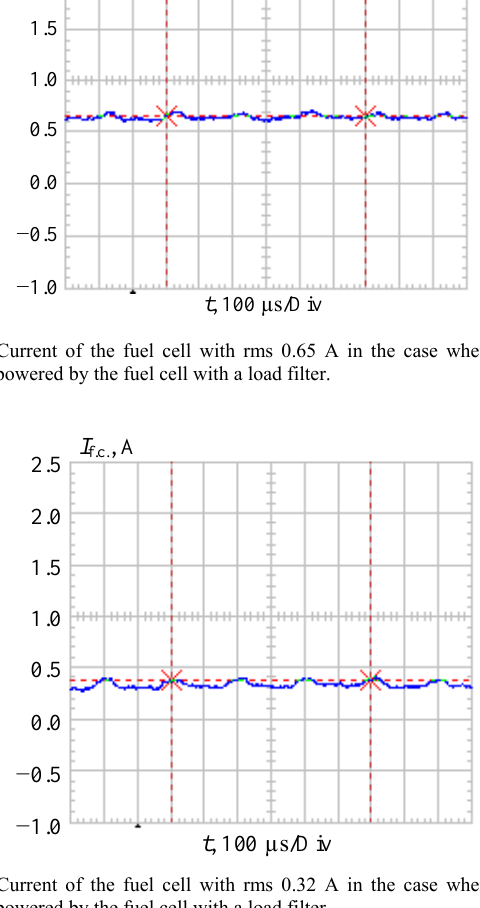
Fig. 12. Current of the fuel cell with rms 0.32 A in the case when load is partially powered by the fuel cell without a load filter.